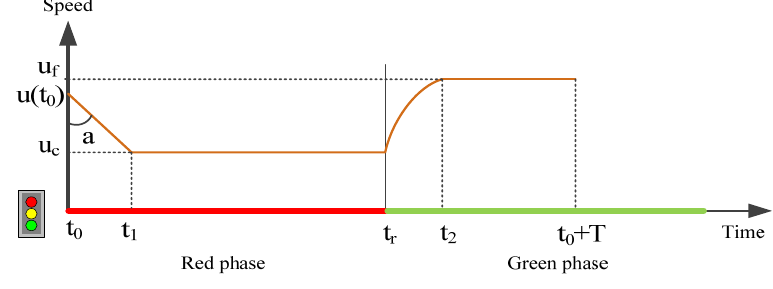
Figure 1. Optimum vehicle speed profile in case 2.